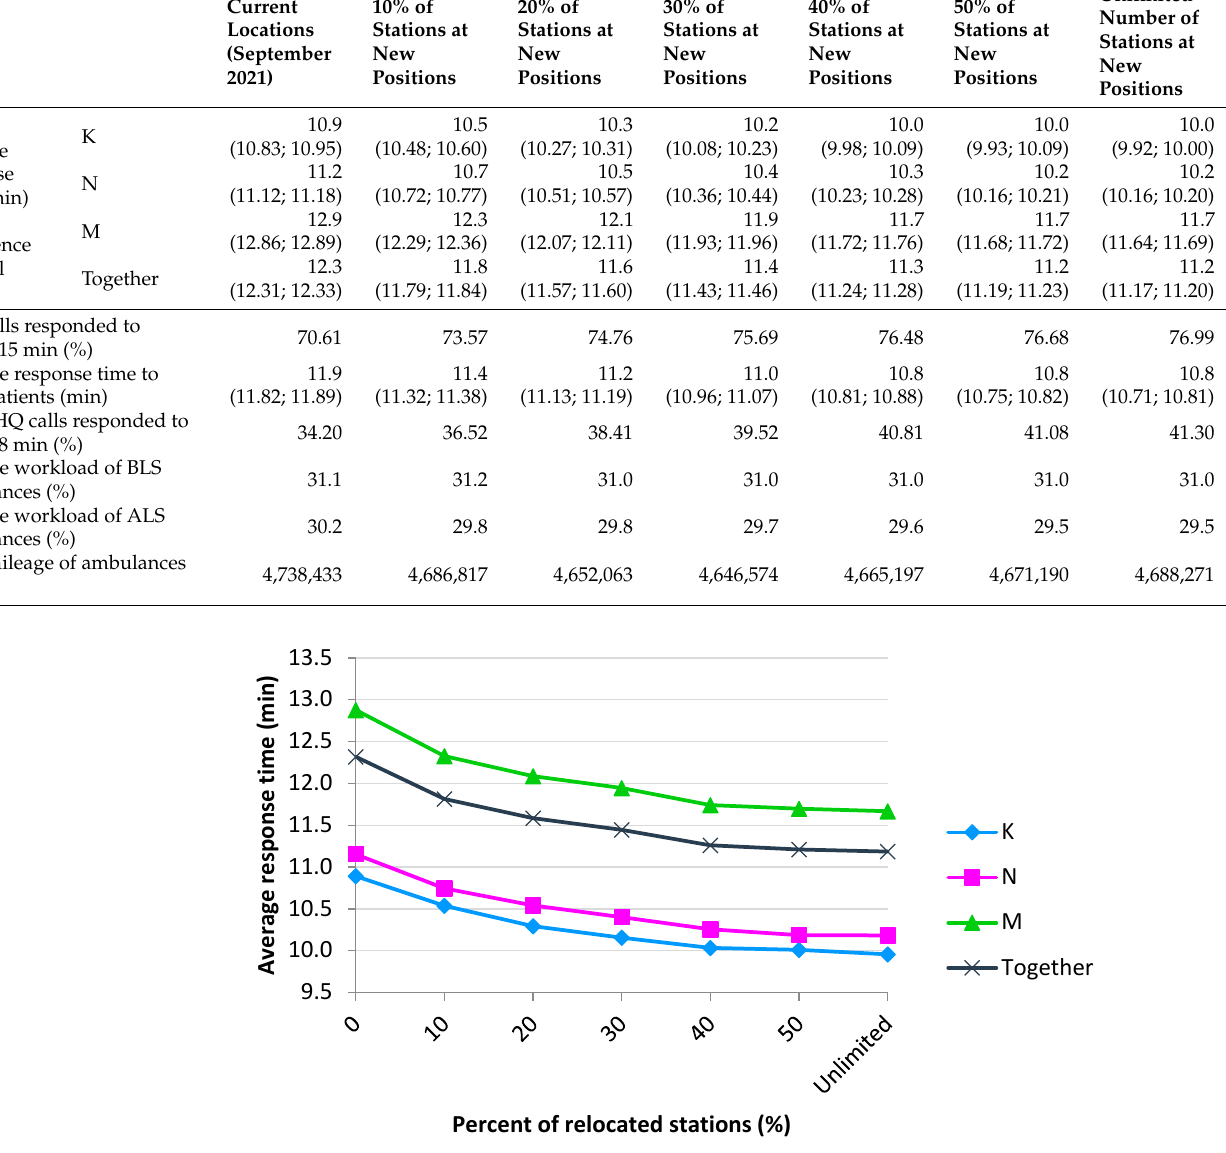
Figure 3. The average response time decreases with increasing level of system optimization. Table 3. Simulation results.